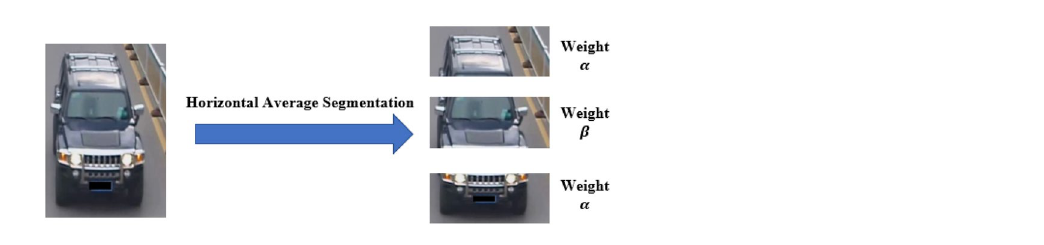
Figure 4. Segmentation and weighted vehicle